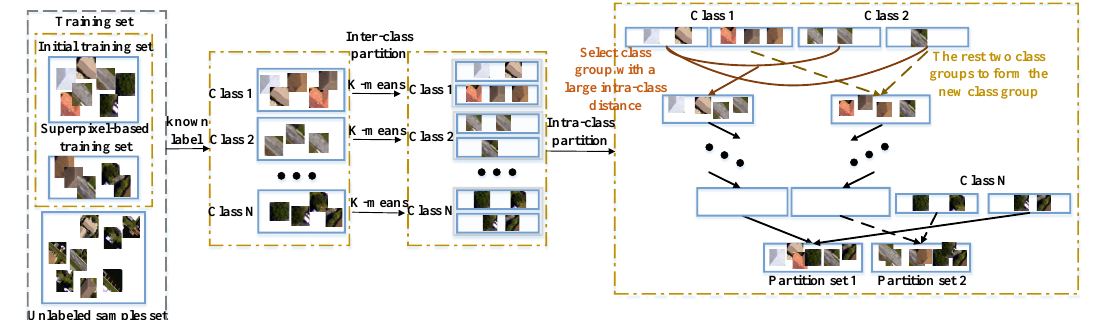
Figure 5. The view partitioning process. Two independent view partition sets are constructed based on the training